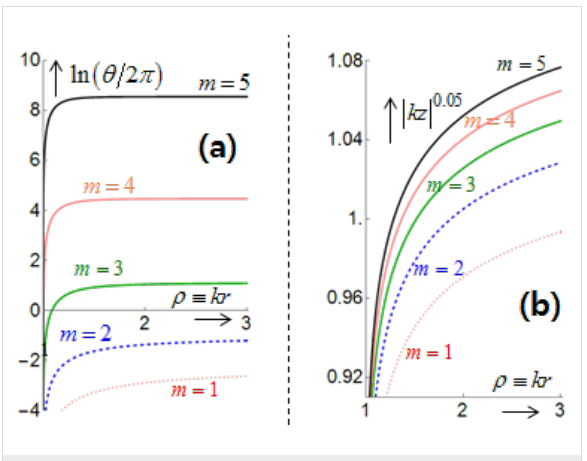
Figure 4: (a) The angle ln( θ /2 π ). (b) The axial displacement | kz | 0.05 with q = i . Both are plotted versus ρ ≡ kr > 1 in the exterior for m = 1,2,3,4,5 and R ρ ≡ kR =